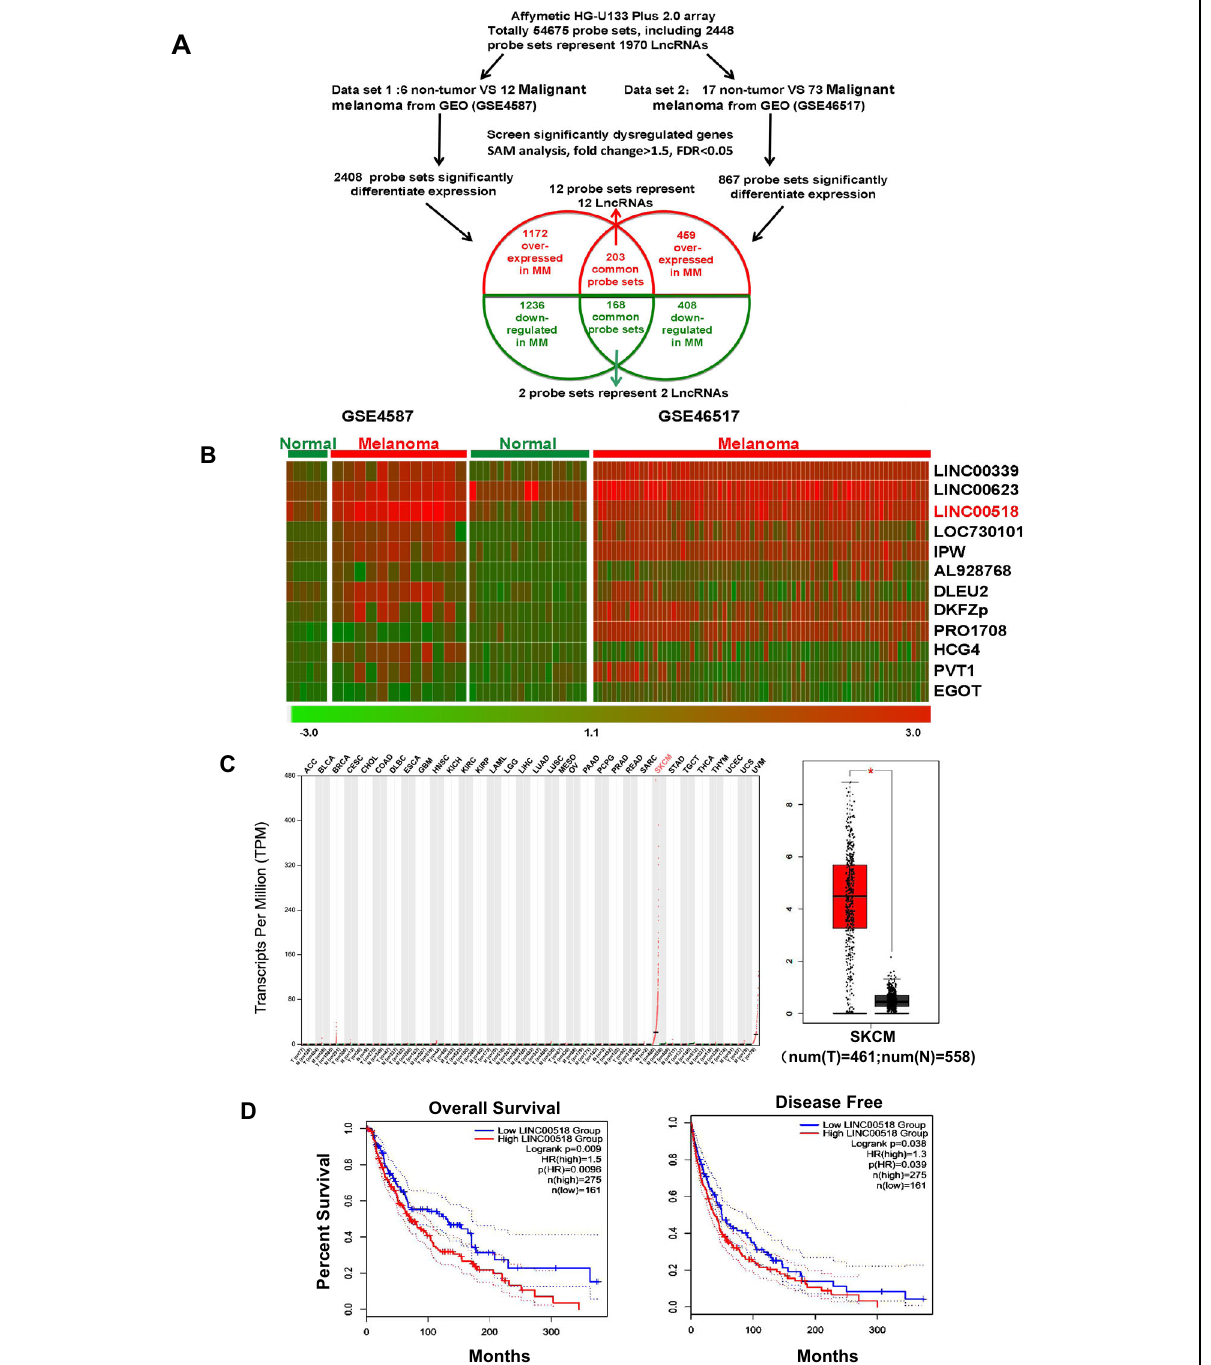
Fig. 1 LINC00518 is overexpressed in CMM and indicates poor prognosis in patients with CMM. A Schematic overview of the work fl ow used to identify and validate dysregulated lncRNAs in two CMM microarray data cohorts. B Heatmap of 12 upregulated probe sets representing 12 lncRNAs mined from the GSE4587 and GSE46517 data sets. C TCGA data showing that the Transcripts Per Million of LINC00518 in CMM was highest in all human cancers and that it is upregulated in CMM compared with normal tissues. D Kaplan – Meier curves of the OS and RFS of 436 patients with CMM with high or low LINC00518 expression. P value was computed by the log-rank test. SKCM stands for skin cutaneous